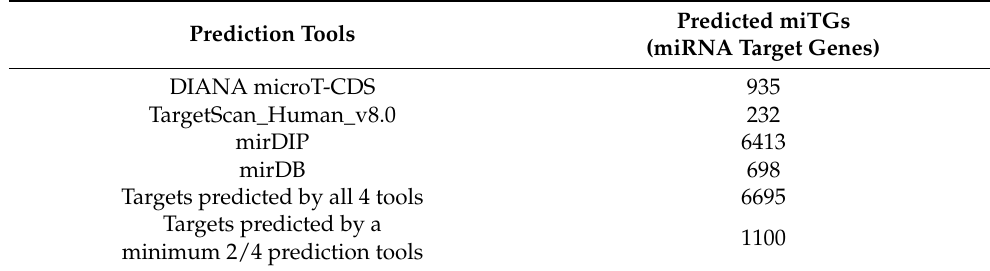
Target genes of hsa-miR-423-5p (miTGs) predicted by DIANA microT-CDS, Tar- getScan_Human_v8.0, mirDIP, and